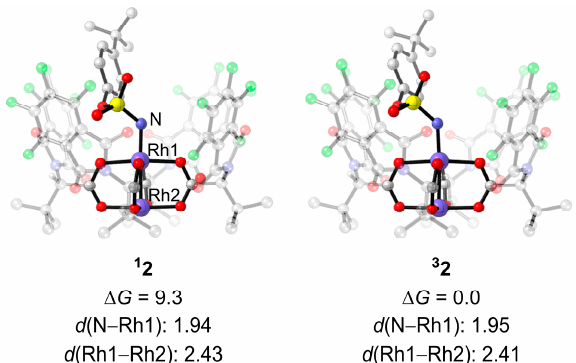
Figure 4. Optimized geometries and energies of the singlet and triplet states of dirhodium–nitrene. Energies are in kcal mol − 1 . Free energy obtained at the ONIOM(M06/def2-TZVP:UFF//BPW91/ 6-31G*-LANL2DZ:UFF) level. The H atoms of t Bu groups and aryl groups are omitted for clarity.